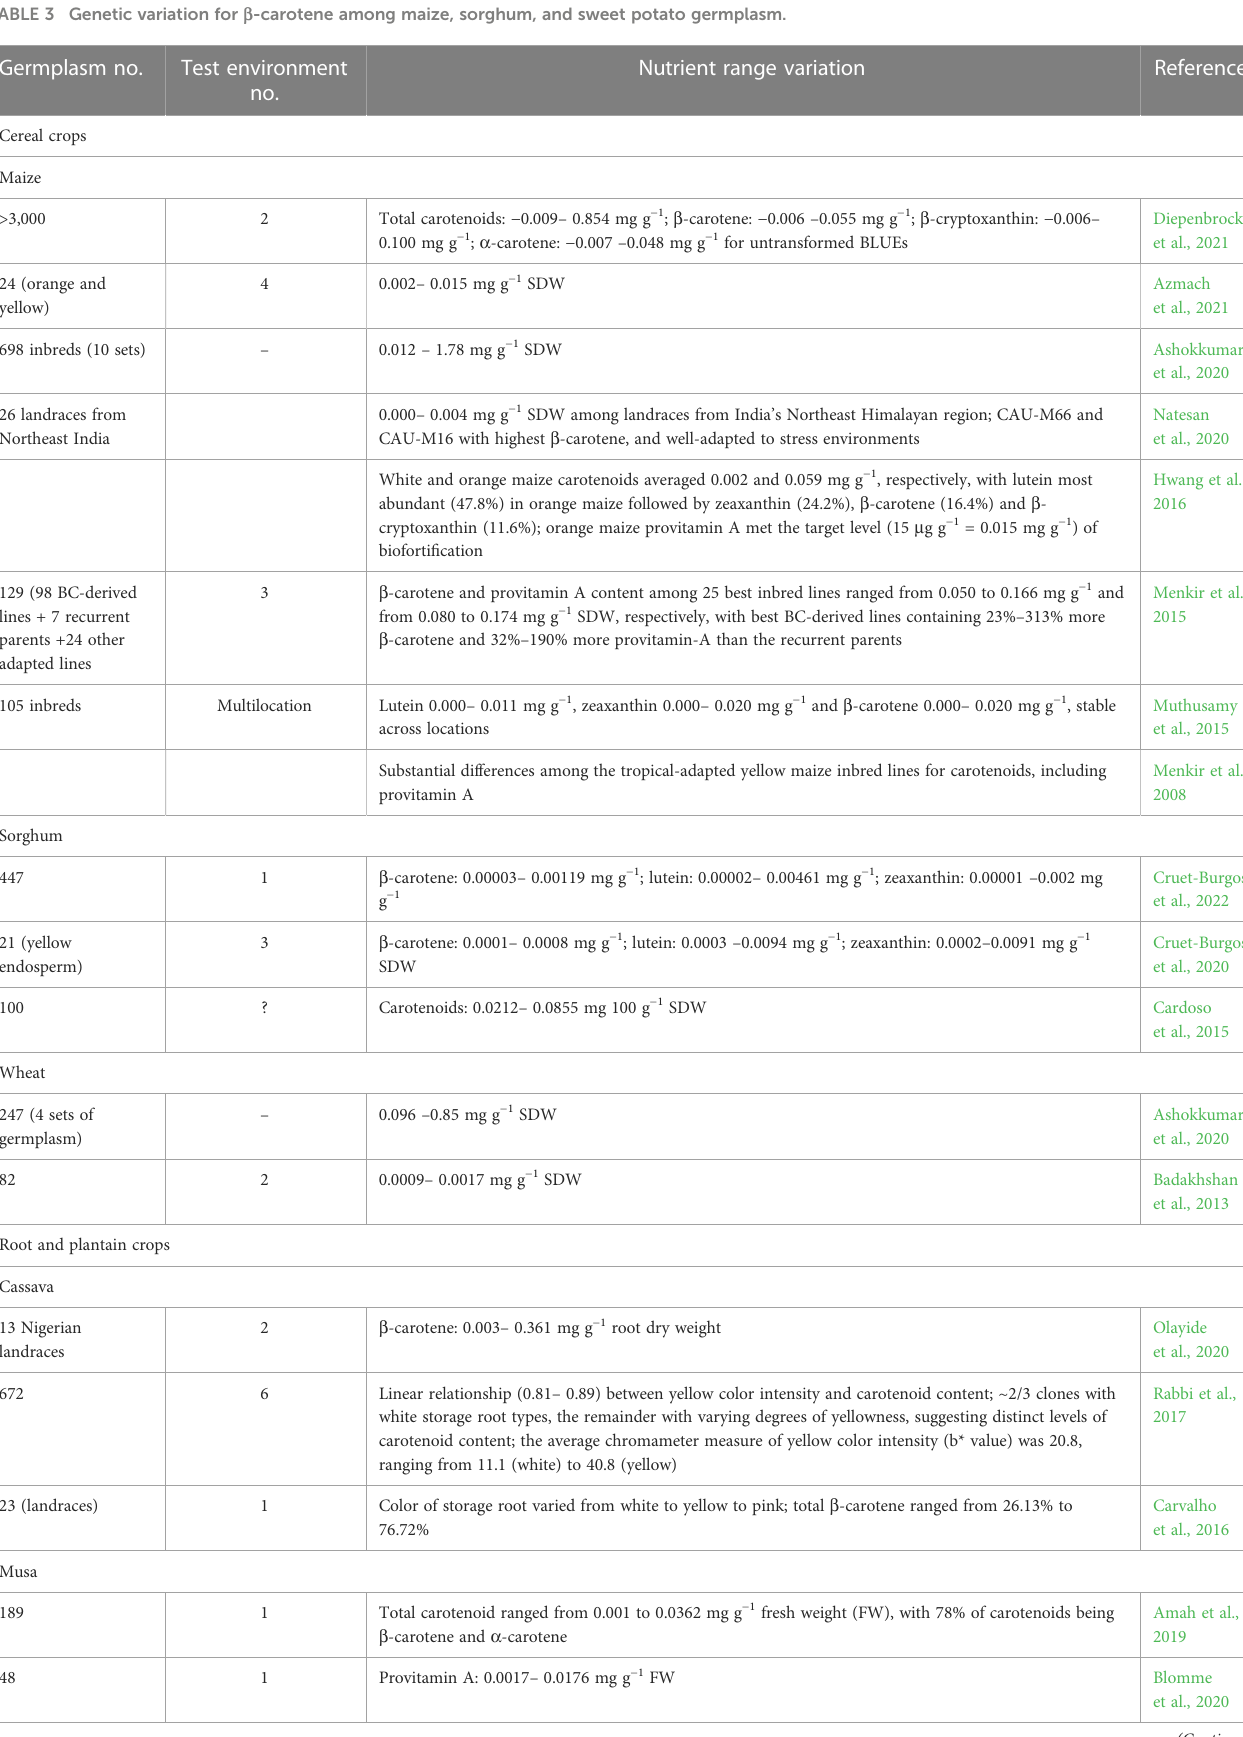
TABLE 3 Genetic variation for b -carotene among maize, sorghum, and sweet potato germplasm. Germplasm